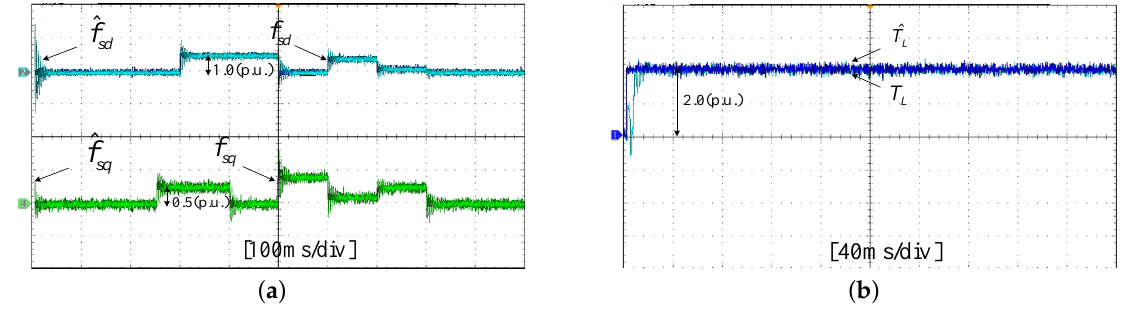
Figure 28. Experimental results of intermittent sensor faults, unknown load and their estimated values. ( a ) Sensor faults f d , f q and their estimated values ˆ f d , ˆ f q ; ( b ) unknown load T L and its estimated value ˆ T L